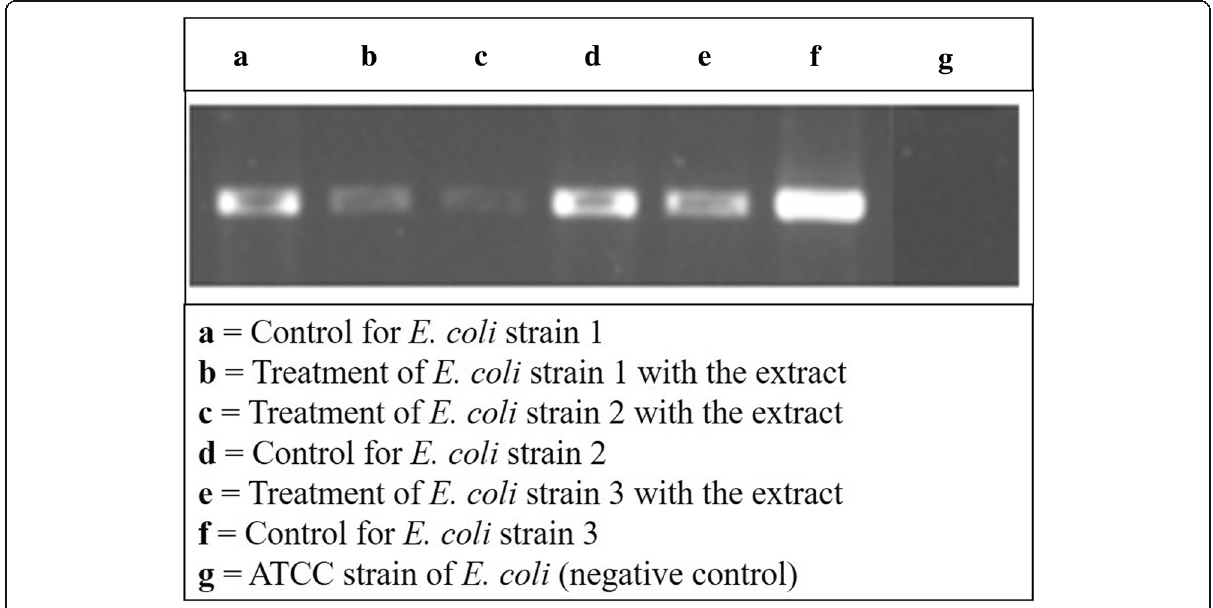
Fig. 4 Gene expression analysis through PCR. PCR amplification of gene encoding CTX-M-15 (410 bp) in control and treated E. coli strains. ( a ) control with strain 1; ( b ) CEA extract treatment with strain1; ( c ) treatment with strain 2; ( d ) control with strain 2; ( e ) treatment with strain 3; ( f ) control with strain 3; ( g ) ATCC (negative control). The figure gives a description about the CTX-M-15 gene expression with and without the treatment of ethyl acetate